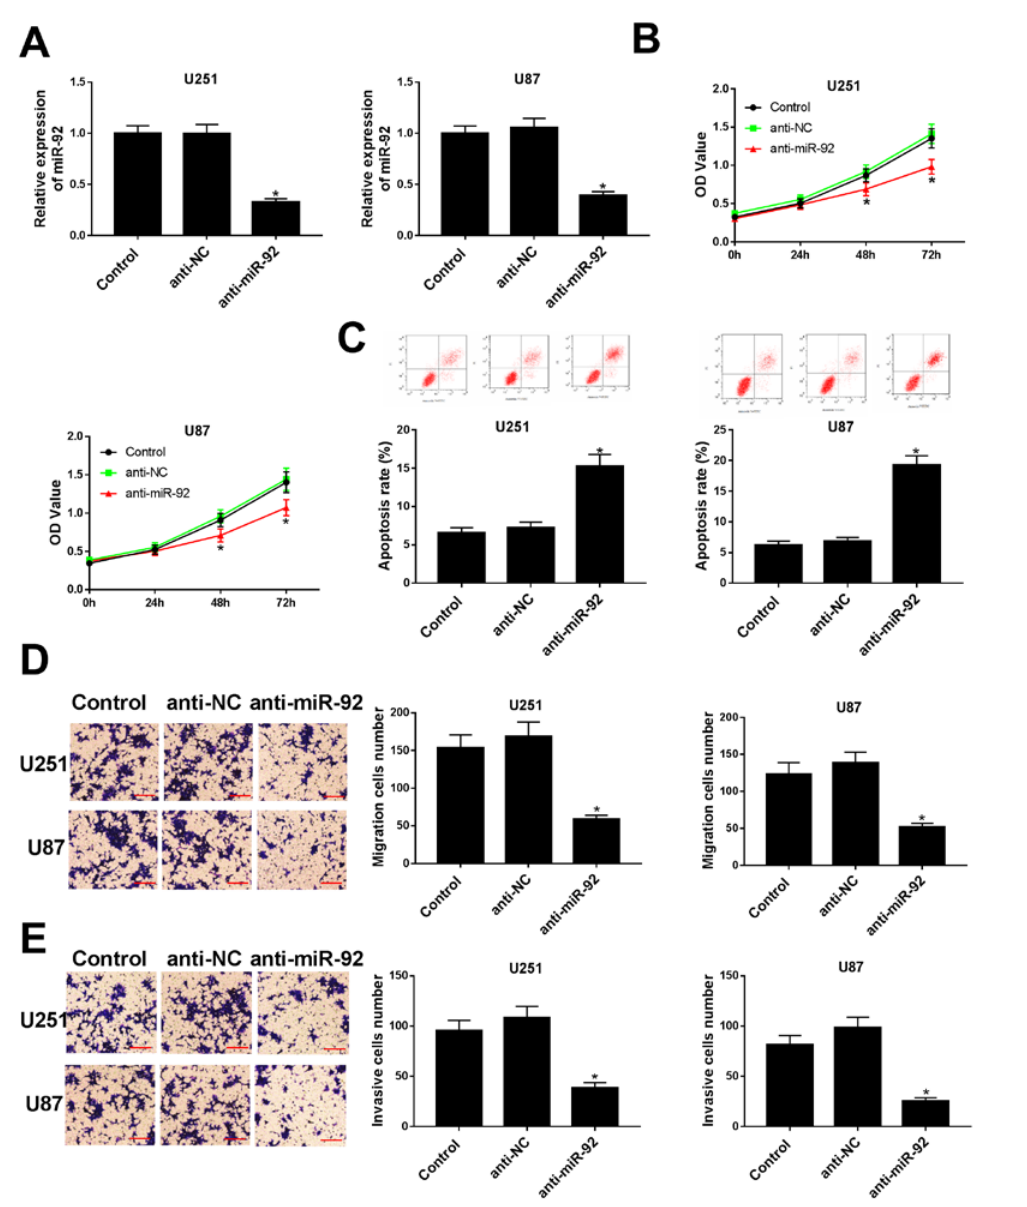
Figure 2: The effects of miR-92 knockdown on the proliferation, migration, invasion and apoptosis of glioma cells. U251 and U87 cell lines were transfected with anti-NC or anti-miR-92. (A) The expression of miR-92 was measured utilizing qRT-PCR assay after transfection. (B) The cell viability was evaluated by MTT assay at different times (24 h, 48 h and 72 h). (C) The cell apoptosis was detected after transfection for 24 h by flow cytometry. (D and E) The migration and invasion abilities were examined after transfection for 24 h by transwell assay. The representative images were presented at 200× magnification. Scale bar: 100 μm. *P <